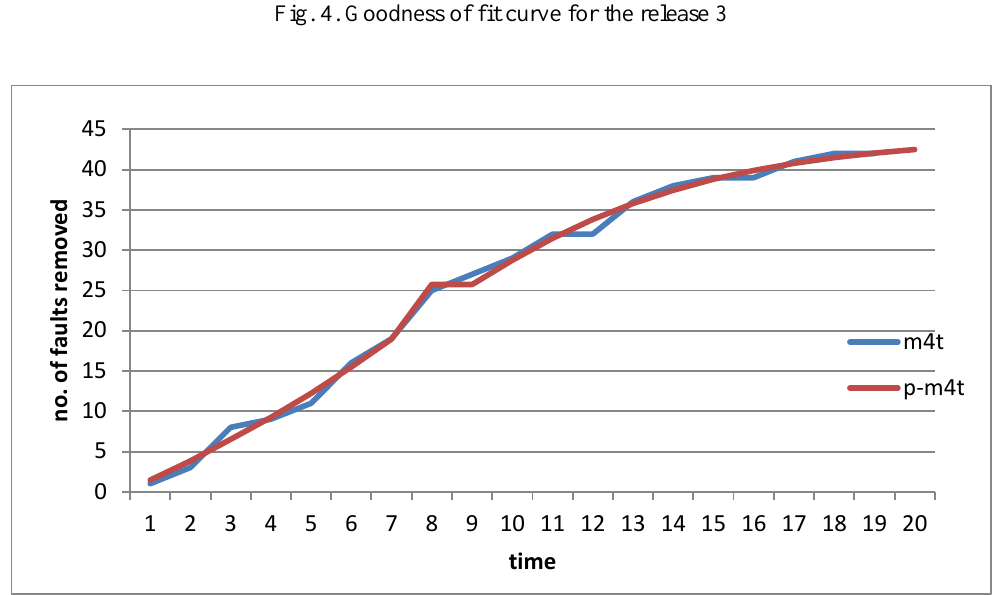
Fig. 5. Goodness of fit curve for the release